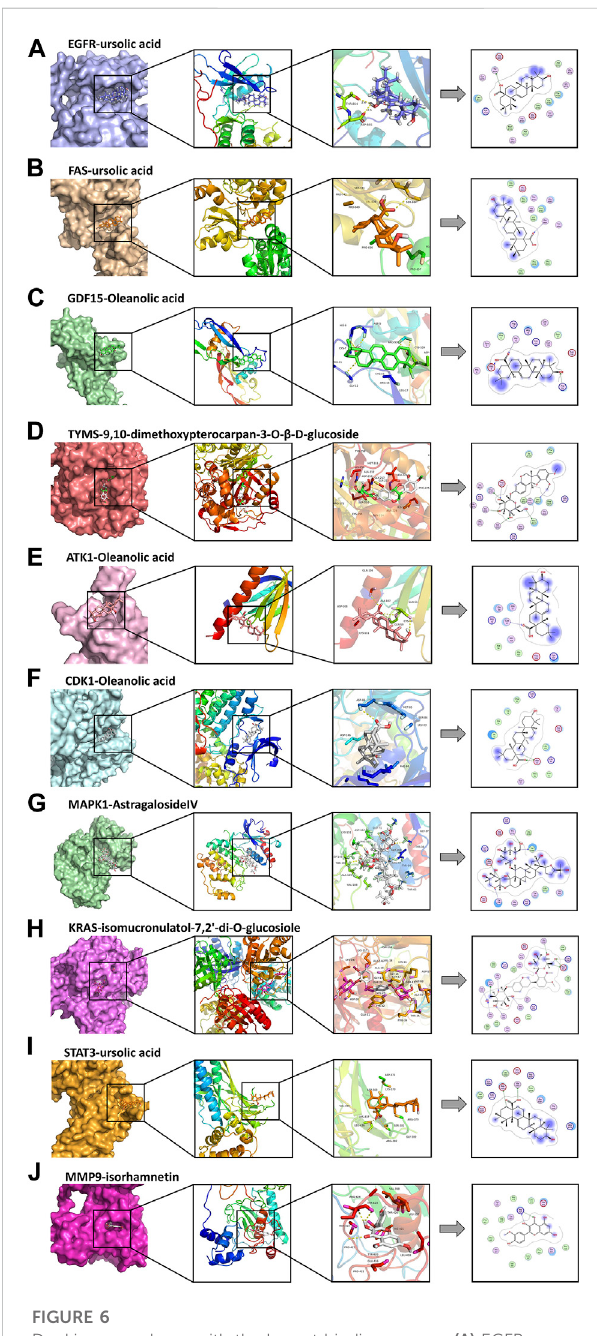
FIGURE 6 Docking complexes with the lowest binding energy: (A) EGFR- ursolicacid; (B) FAS-ursolicacid; (C) GDF15-Oleanolicacid; (D) TYMS- 9,10-dimethoxypterocarpan-3-O- β -D-glucoside; (E) ATK1-Oleanolic acid; (F) CDK1-Oleanolic acid; (G) MAPK1-AstragalosideIV; (H) KRAS-isomucronulatol-7,2 ’ -di-O-glucosiole; (I) STAT3-ursolic acid; (J)